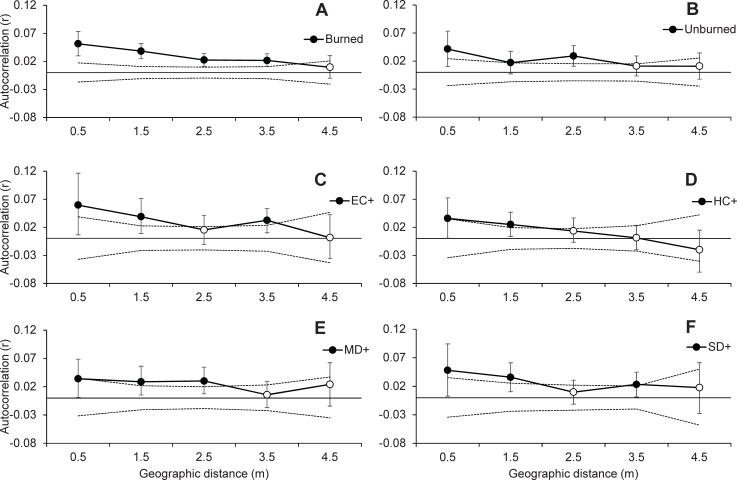
Local Spatial Genetic Structure of Cistus ladanifer in A) burned combined, B) unburned combined, C-F burned and drought plots at the within-plot scale. EC+: Environmental Control, HC+: Historical Control, MD+: Moderate Drought, SD+: Severe Drought (see text for details). Symbols indicate mean r-values per distance class, filled symbols indicate significant spatial autocorrelation. Dashed lines represent 95% confidence intervals as determined by 9,999 permutations; symbols outside of confidence intervals indicate significance. Error bars depict the 95% confidence interval about r as determined by 10,000 bootstrap resampling.